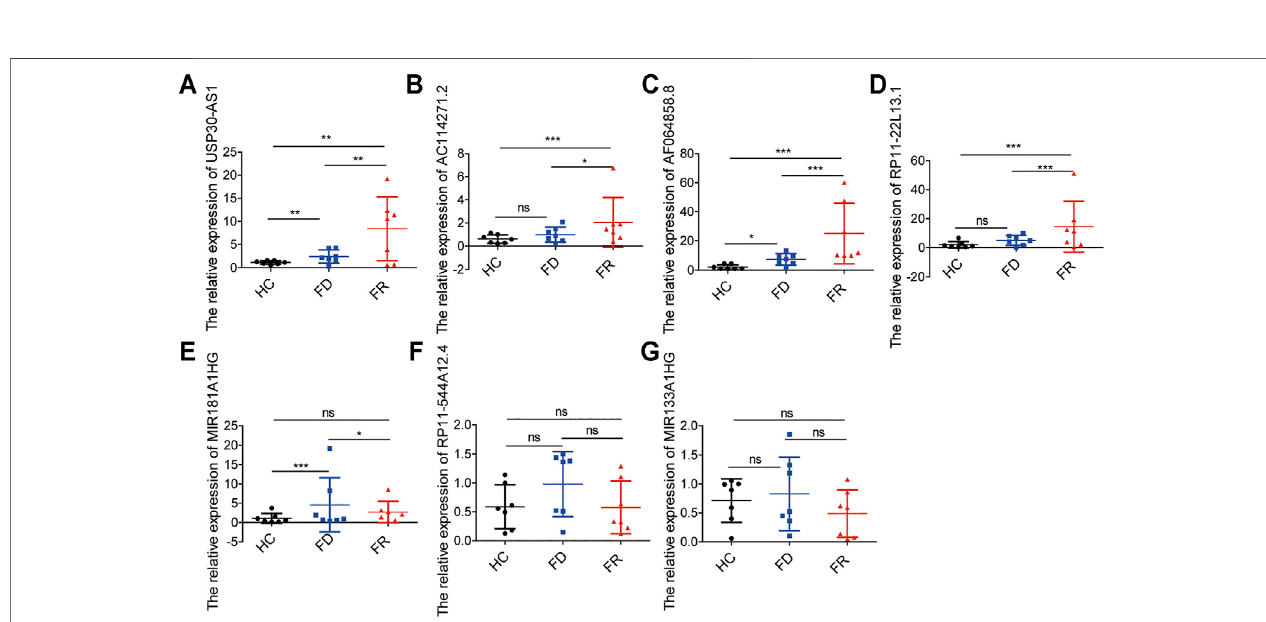
FIGURE7| Theexpression levelsofseven m6A-related lncRNAs inAML samples (A – G) theexpression levelsofseven lncRNAs inthe signature detected byqRT- PCR, HC, Healthy Controls; FD, First Diagnosis; FR, First Relapse. * p < 0.05; ** p < 0.01; *** p < 0.001.